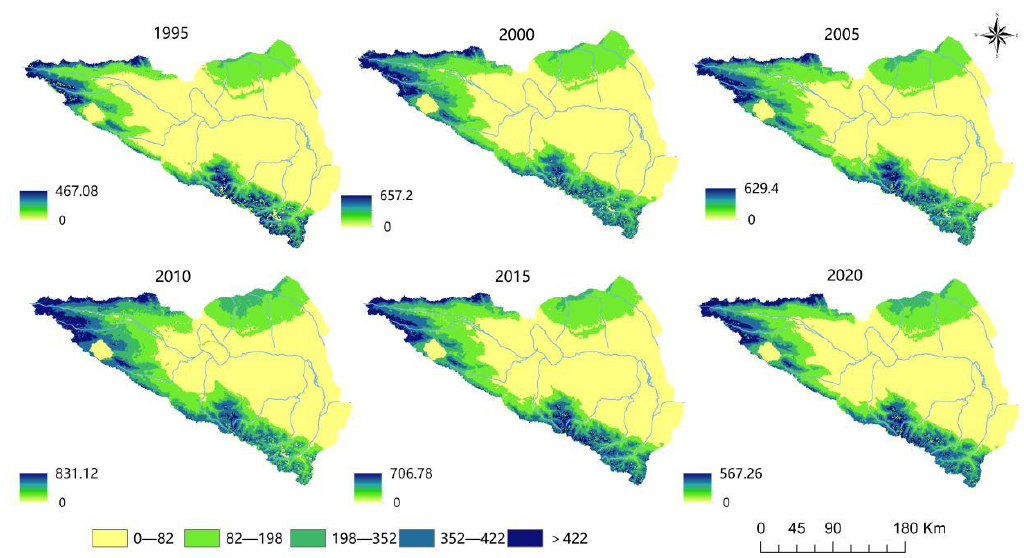
Figure 6. Spatial distribution characteristics of water yield grade in the Ebinur lake Basin. The area of land-use types and the relationship between the change in water yield and the average depth of water yield in the basin are shown in Figure 7. The values of different land-use types contributing to water yield in the basin, in descending order, are as follows: forest land > grassland > water area > unused land > cropland > built-up land. The area of built-up land and cropland in the Ebinur Lake Basin increases year by year. The area of unused land decreases yearly. The forest land, grassland, and water area have more fluctuations. Additionally, forest land and grassland contribute more to the average water yield and are the main contributing land types. From 1995 to 2010, the major trend in the water yield of cropland, built-up land, and average water yield depth were all increasing and positively correlated. 2010–2020 is a negative correlation. The area of grassland and forest land accounts for 50.23% of the total area of the region, which makes the average multi-year water yield of forest land and grassland higher. The average annual water yield of forest land and grassland is 135.39 × 10 6 m 3 and 119.31 × 10 6 m 3 , respectively. This finding is followed by cropland and unused land, 96.37 × 10 6 m 3 and 88.22 × 10 6 m 3 , respectively. Forest land, grassland, and unused land types were negatively correlated with water yield from 1995 to 2010, and the trend was consistent and positive from 2010 to 2020. The trends in water types were consistent and positively correlated only in 1995–2005. The other periods showed the opposite variation. There is a large difference in the relationship between average water yield and type-area change on each land-use type. On the one hand, this difference in the relationship between average water yield and type-area change is due to land-use cover and land-use change. On the other hand, it is closely related to the influence of climate change and human activities on water